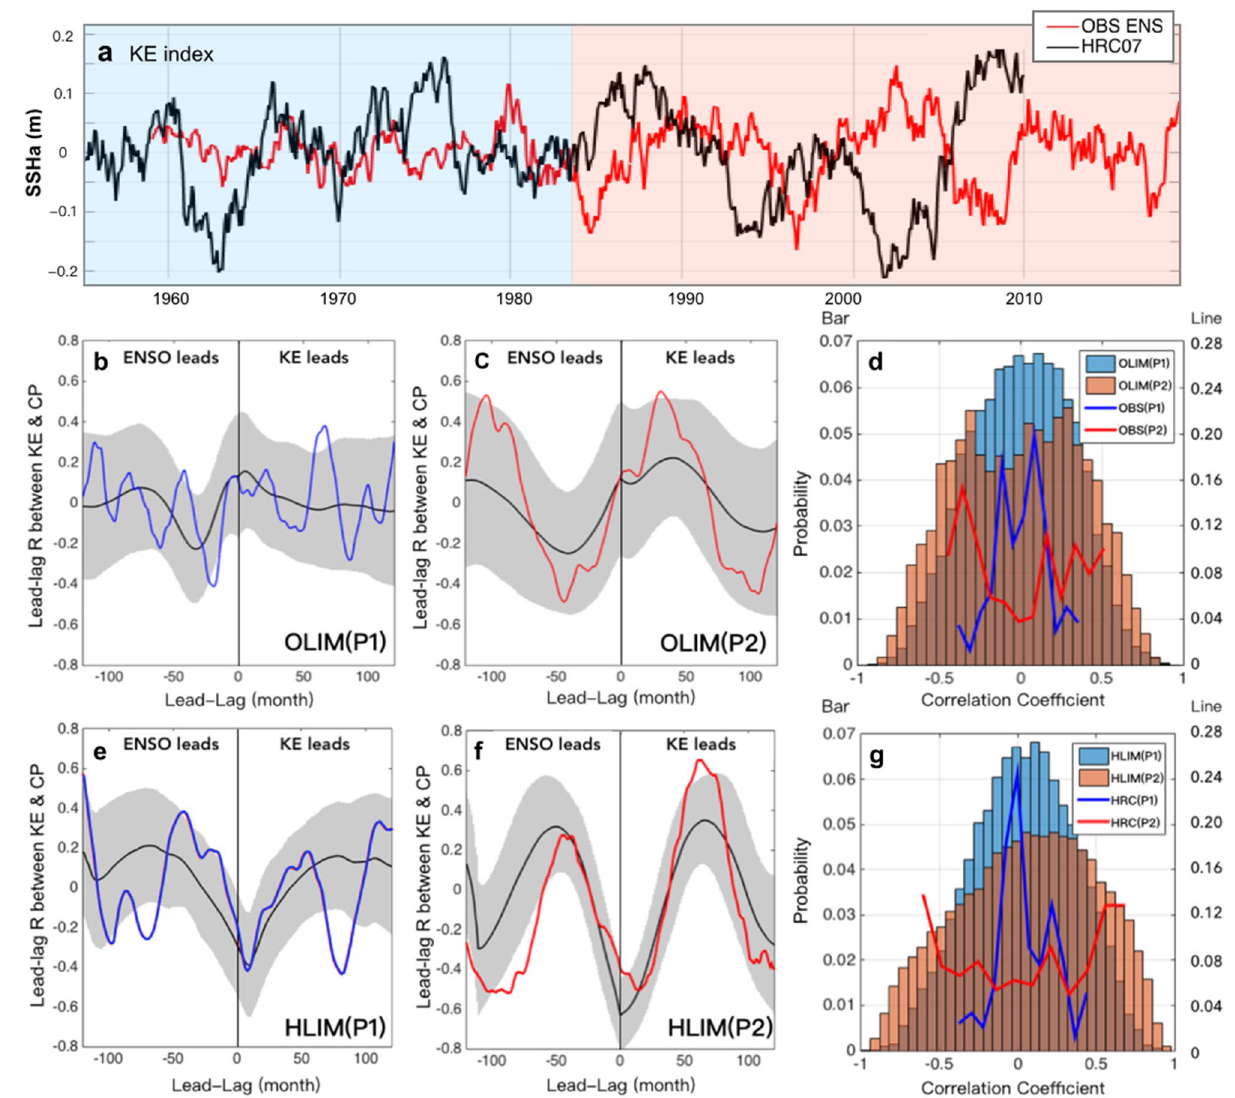
Figure 3. Changes in the temporal KE variability and coupling between the KE and CP-ENSO from Period 1 to Period 2. ( a ) Computed KE index using area-averaged SSH anomalies over the KE region from the observational ensembles (ORA and AVISO, red line) and HRC (historical run-no assimilation, black line). Lead-lag correlation between the KE and CP-ENSO indices during the ( b ) P1 and ( c ) P2 in LIM constructed by observational SSH and SST (OLIM), where black and blue/red lines are each the ensemble mean, and the observed correlation and shadings show plus and minus two standard deviations in the mean values. ( d ) Probability distribution function of the observed (lines) and reconstructed (bars) correlation coefficients of the panel b and c for the P1 and P2 respectively. Panels ( e , f , and g ) are same as ( b , c , and d ), but for LIM constructed by HRC SSH and SST